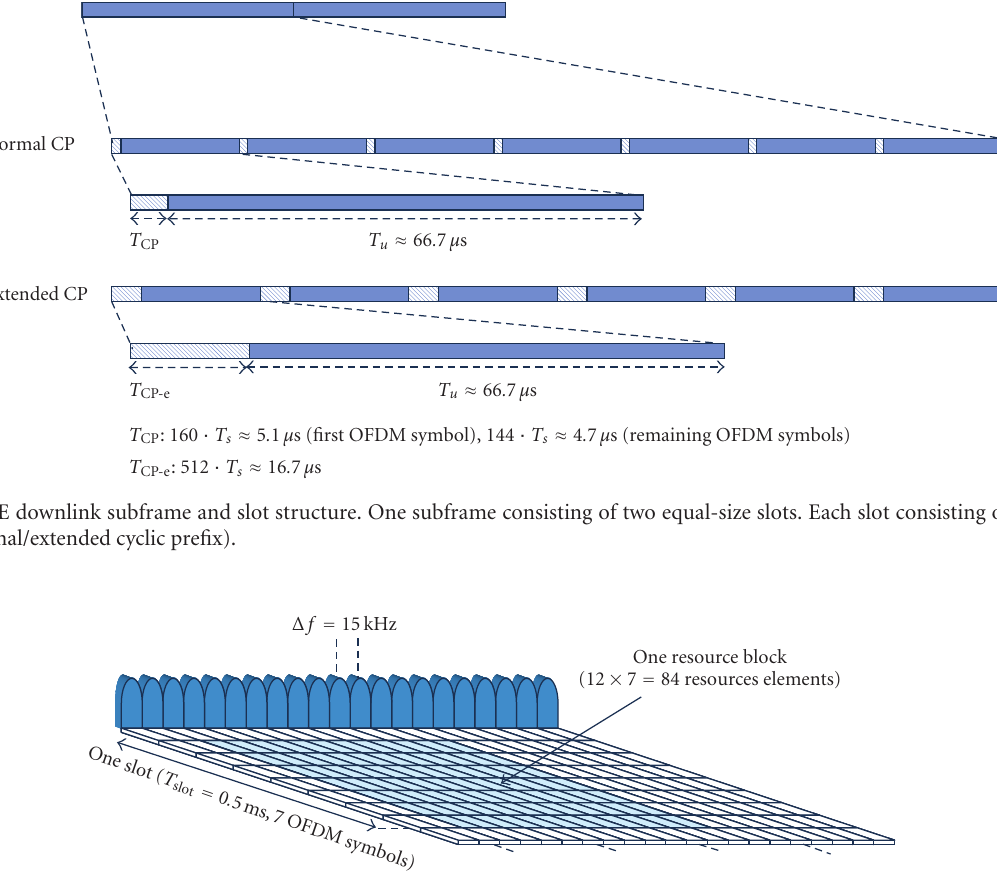
Figure 21: Downlink resource block assuming normal cyclic prefix. With extended cyclic prefix there are six OFDM symbols per slot and, consequently, 72 resource elements per resource